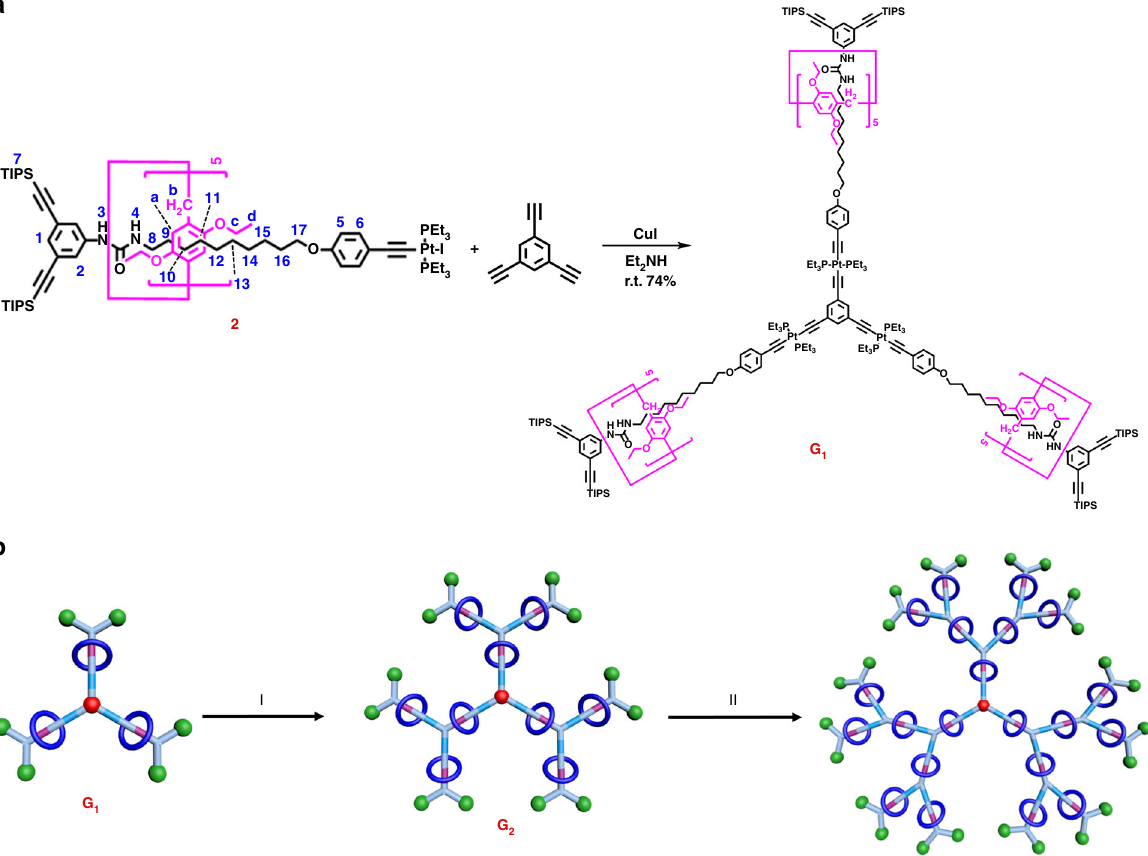
Fig. 3 a Synthesis of rotaxane-branched dendrimer G 1 by a CuI-catalyzed coupling reaction of [2]rotaxane building block 2 and 1,3,5-triethynylbenzene; b schematic representation of a controllable divergent approach for the synthesis of rotaxane-branched dendrimers G 2 and G 3 . Reaction conditions: (I) (a) TBAF, THF, r.t., 4 h, 92%; (b) 2 , CuI, Et 2 NH, r.t., 8 h, 62%; (II) (a) TBAF, THF, r.t., 4 h, 60%; (b) 2 , CuI, Et 2 NH, r.t., 8 h,